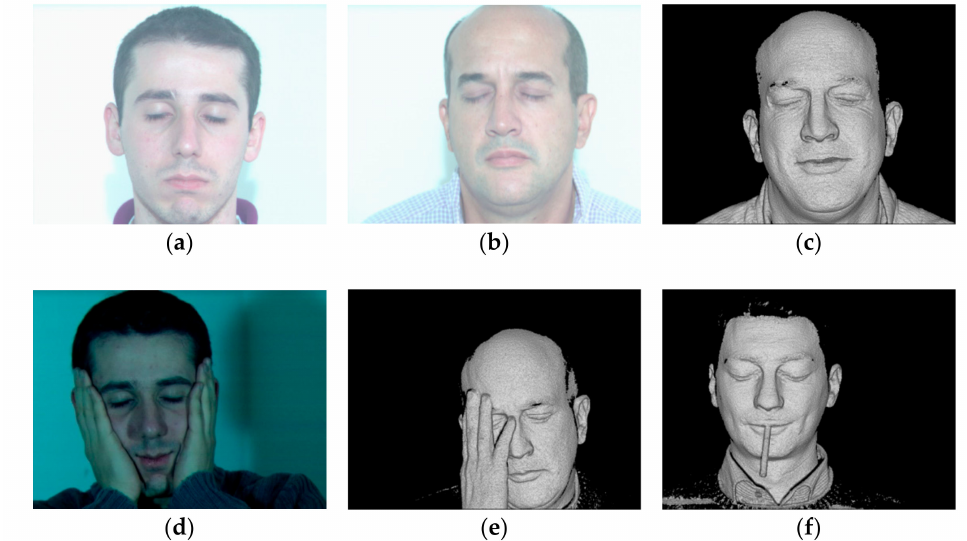
Figure 5. Image results based on The University of the Milano Bicocca 3D Face Dataset (UMB- DB) database, ( a ) expression image-1, ( b ) expression image-2, ( c ) expression image-3, ( d ) occlusion image-1, ( e ) occlusion image-2, ( f ) occlusion